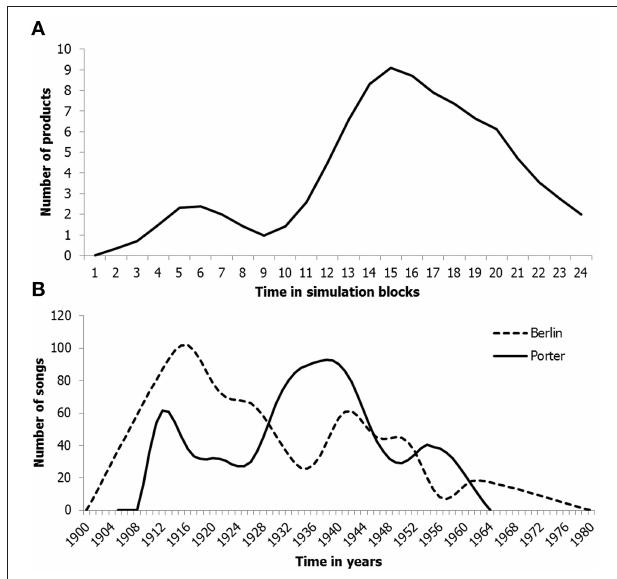
FIGURE 9 | Illustration of a single individual’s simulated productivity across the life span (A) and the life span productivity of the songwriters Irving Berlin and Cole Porter (B). In Graph (A) the time axis corresponds to time blocks, i.e., 24 periods of 20 time